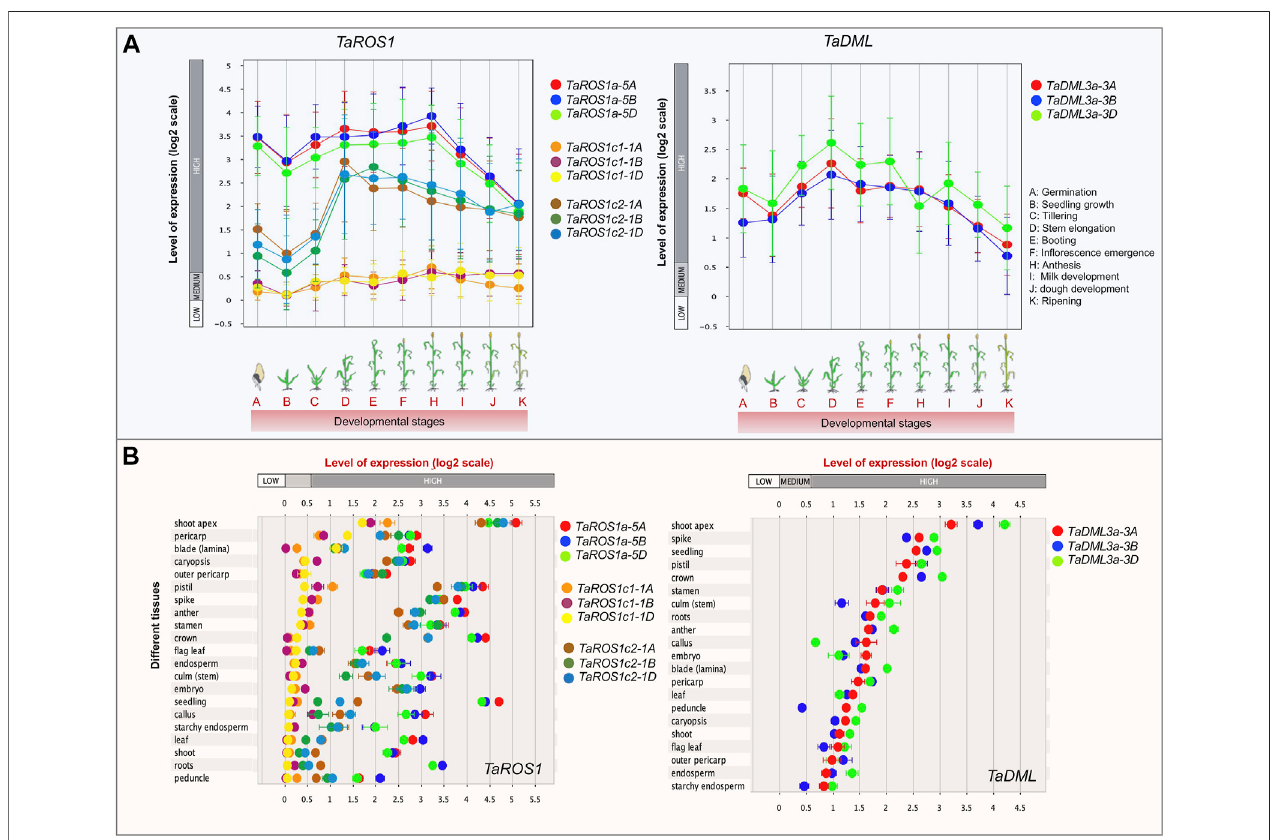
FIGURE 6 | Expression pro fi les of wheat dMTase in the different developmental stages (A) and wheat tissues (B) . Showing the scatterplots for the 12 TadMTase genes, the left side in (A) and the topside in (B) represent the change of gene expression using the base 2 logarithm scale. Different dMTase genes are represented by distinct colors as indicated. Error bars represent standard errors. Data were analyzed with the Genevestigator